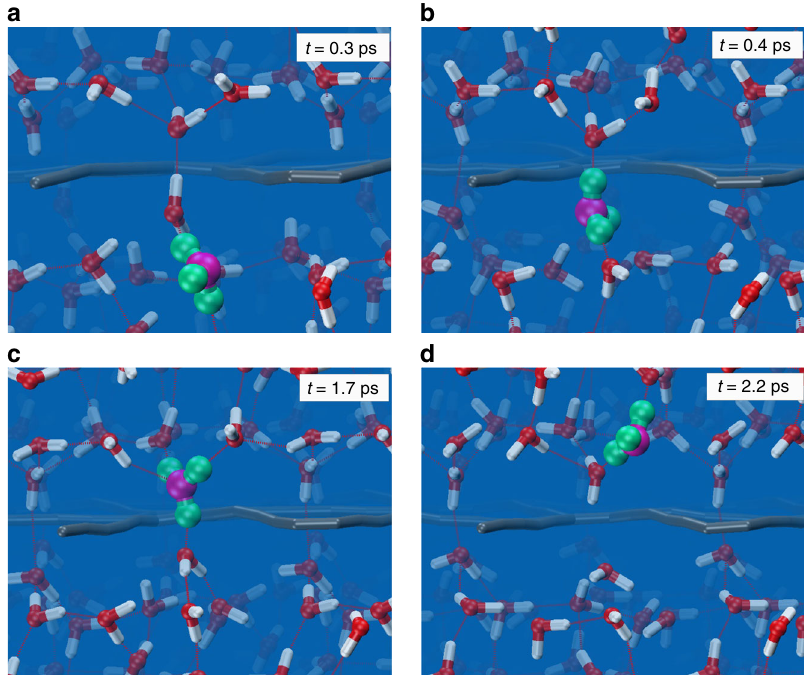
Fig. 3 The process of trans-membrane proton transport. a – d The chronological snapshots for proton transport across graphdiyne membrane via the Grotthuss mechanism in Traj_1 of Fig. 2a. Color code: C, gray; H, white; O, red; H in H 3 O + complex, green; O in H 3 O + complex,